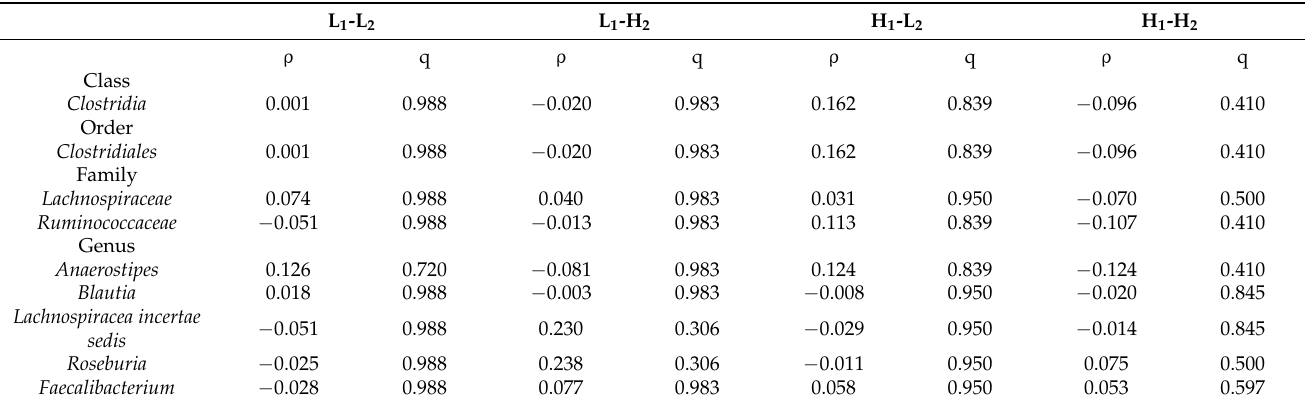
Table 6. Correlation of the amount of the change for one year between water-soluble dietary fiber intake and butyric acid-producing bacteria abundance.